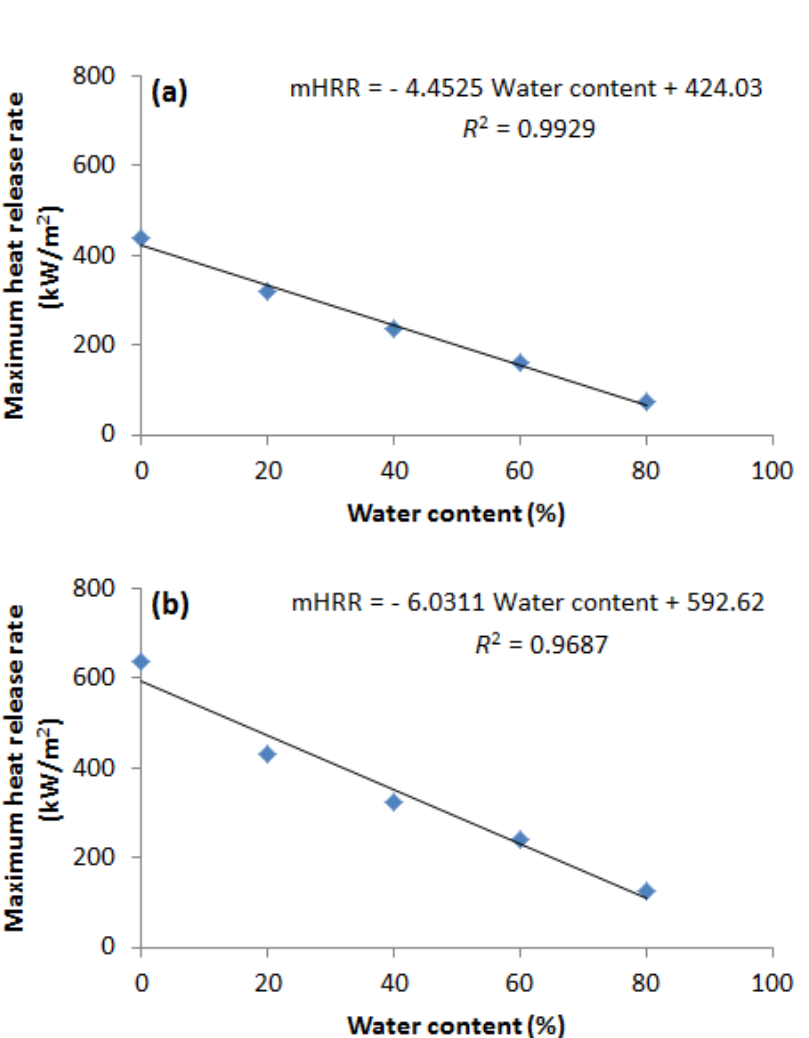
Figure 3. Dependency of the maximum heat release rate of investigated fuels on the water content: ( a ) Dependency of the maximum heat release rate of methanol on the water content; ( b ) Dependency of the maximum heat release rate of ethanol on the water content (mHRR: maximum heat release rate).